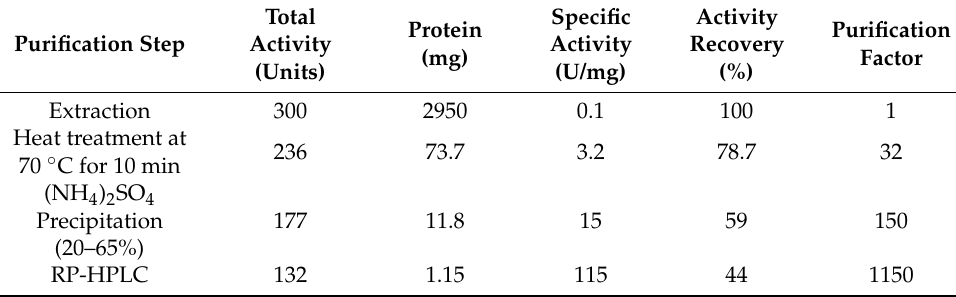
Table 1. Flow sheet of DrPLA 2 -V purification.